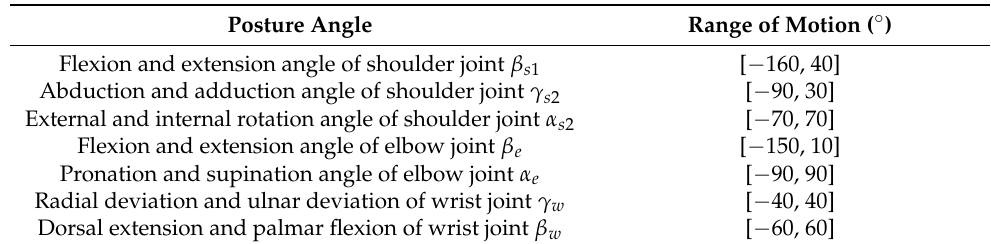
Table A1. The posture angle range of each motion platform of the humanoid manipulator. Posture Angle Range of Motion ( ◦ ) Flexion and extension angle of shoulder joint β s 1 [ − 160, 40] Abduction and adduction angle of shoulder joint γ s 2 [ − 90, 30] External and internal rotation angle of shoulder joint α s 2 [ − 70, 70] Flexion and extension angle of elbow joint β e [ − 150, 10] Pronation and supination angle of elbow joint α e [ − 90, 90] Radial deviation and ulnar deviation of wrist joint γ w [ − 40, 40] Dorsal extension and palmar flexion of wrist joint β w [ − 60,